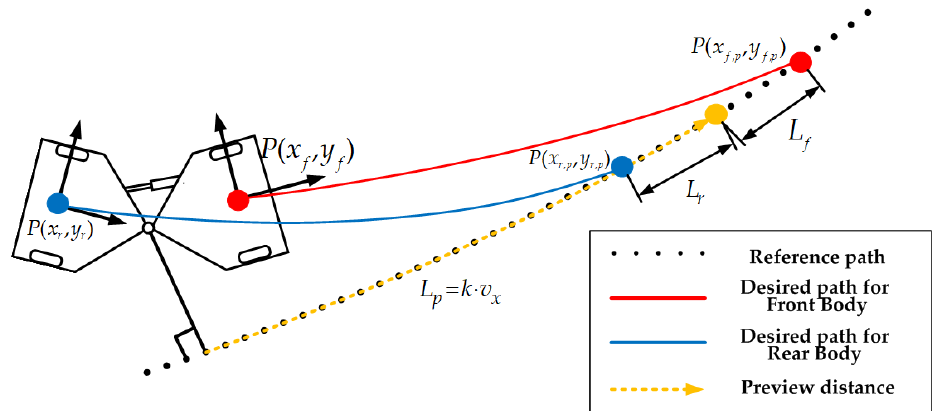
Figure 4. Desired path for both bodies of the AAEV.